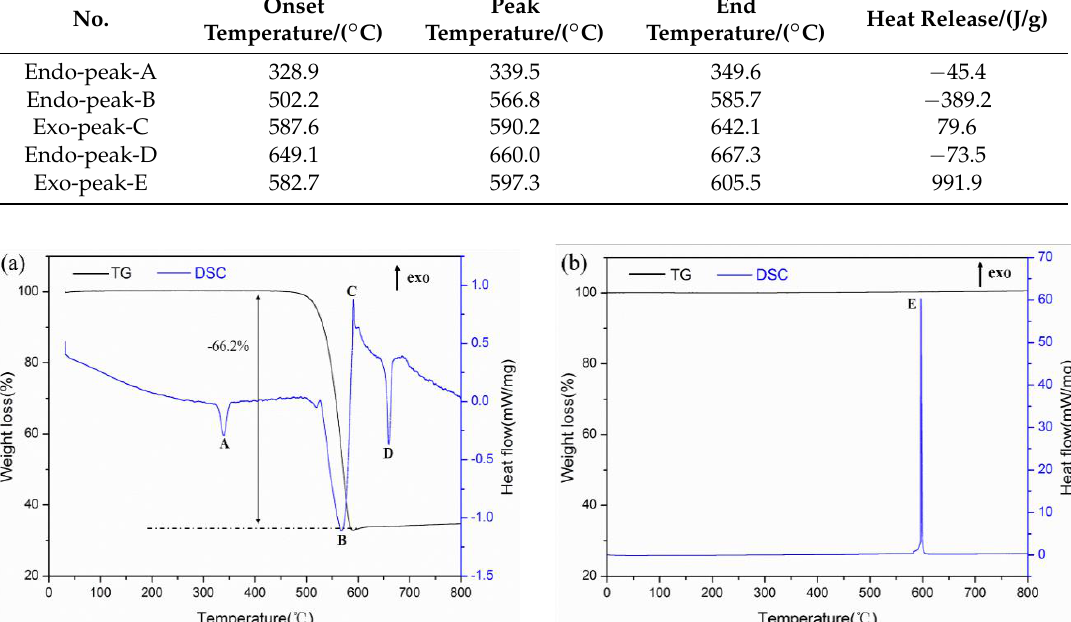
Figure 4. The TG-DSC curves for the Al-PTFE and Al-Ni mixtures: ( a ) The Al-PTFE mixture; ( b ) the Al-Ni mixture.